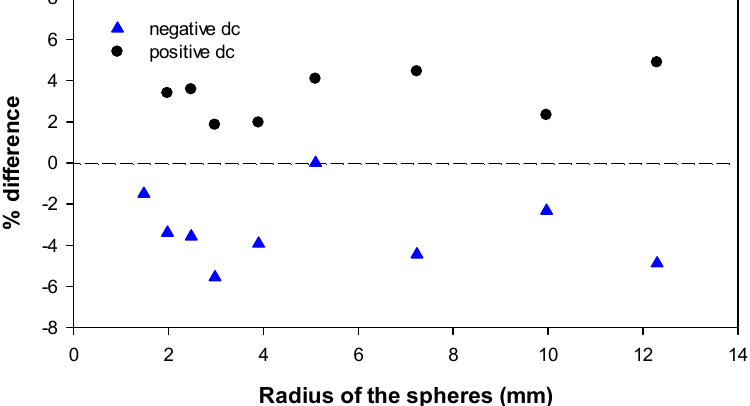
Figure 6. Percentage difference of the visual corona extinction electric field strength versus the curvature radius of the sphere. The ac value is taken as the reference. Energies 2018 , 11 , x FOR PEER REVIEW